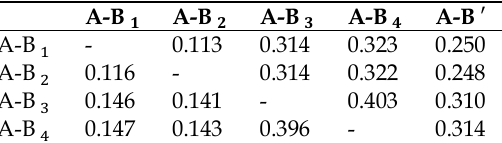
Table 2. Recapture ratios for